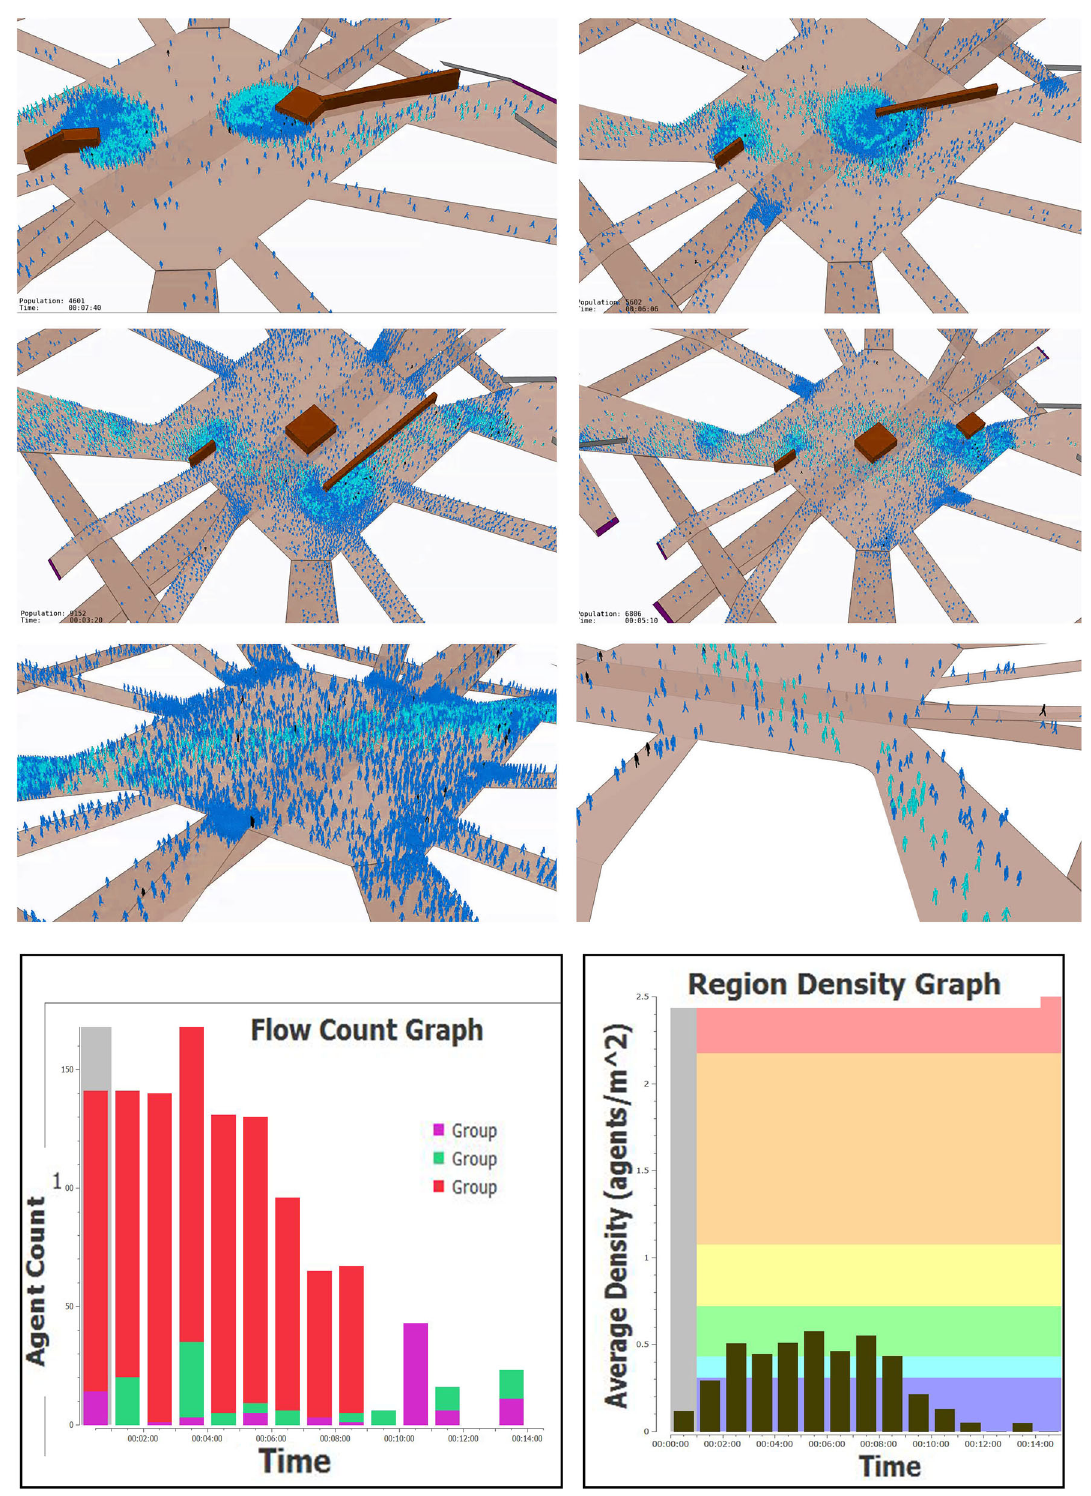
Fig. 4 Adaptive urban model, Xuzhou, China. Multiple design iterations were simulated with projected pedestrian flow. Top The agent with dark blue and light blue represents two route groups of pedestrian flow and their interaction in the proposed central square. The designers simulated four spatial layouts with different partition